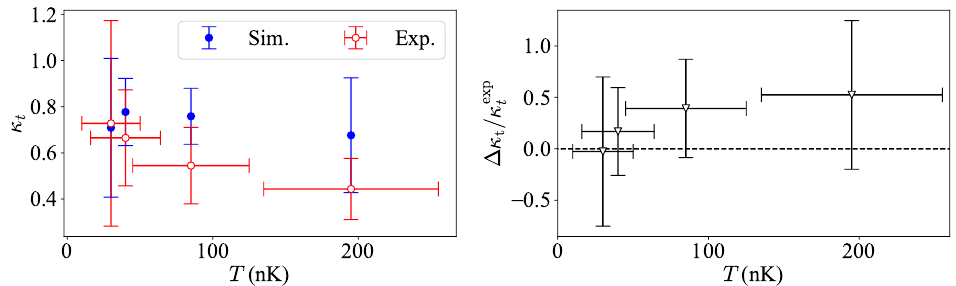
Figure 9: The normalised barrier height for which the decay timescale is predicted to be τ = 1s, κ , as a function of temperature. (Left) Comparison between the ex- t perimental (red open circles) and simulation values (blue filled circles). The experi- mental trend is monotonically decreasing in temperature, which is not qualitatively reflected in the simulation trend. (Right) The relative discrepancy between the simu- = κ sim − κ exp lation and the experimental values, where ∆ κ . The dashed horizontal t t t = 0. The error between the experimental and simulation values line illustrates ∆ κ t increases monotonically with temperature. Error bars give a 95% confidence